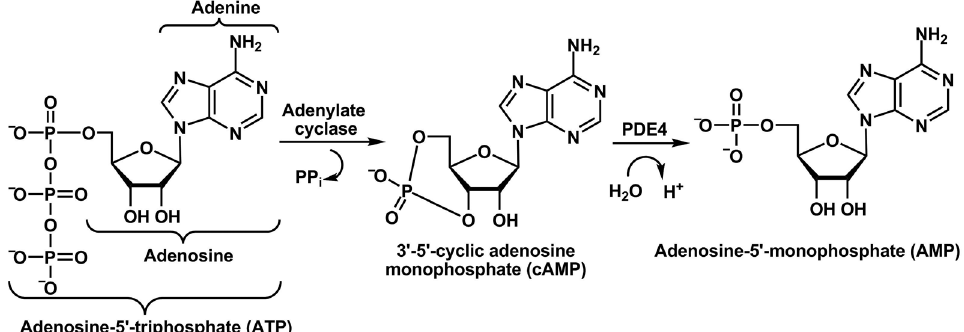
FIGURE 3 - Biosynthesis of cAMP by adenylate cyclase and its hydrolysis to adenosine-5’-monophosphate (AMP) by the action of phosphodiesterase 4 (PDE4).